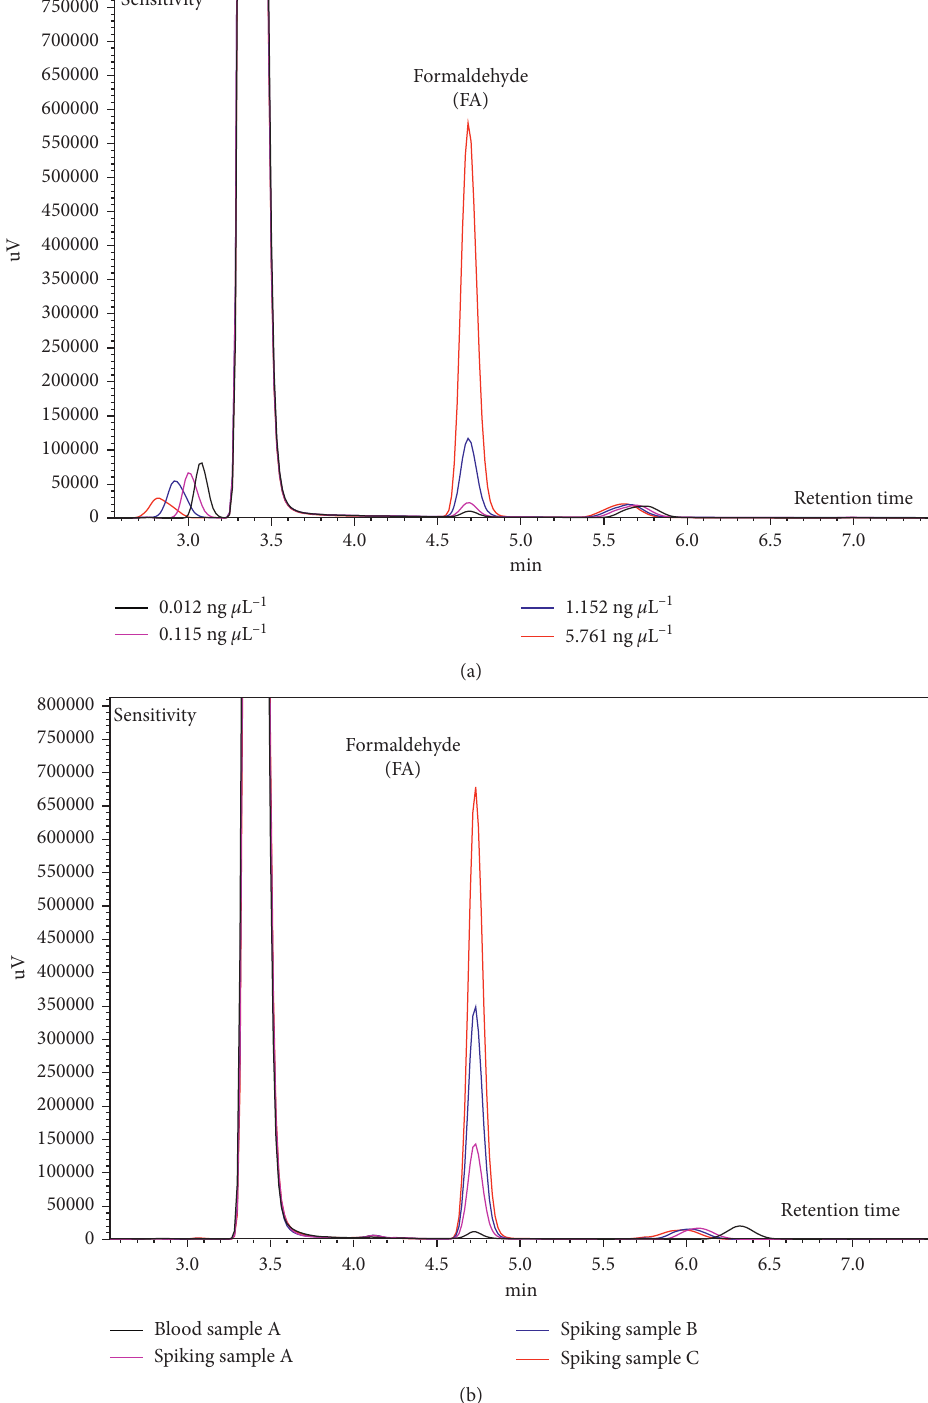
Figure 2: Chromatograms of FA with different experiments. (a) Exp 1b: chromatograms of FA in the final working standards. (b) Exp 2 and 3: chromatograms of FA in blood sample A and spiked